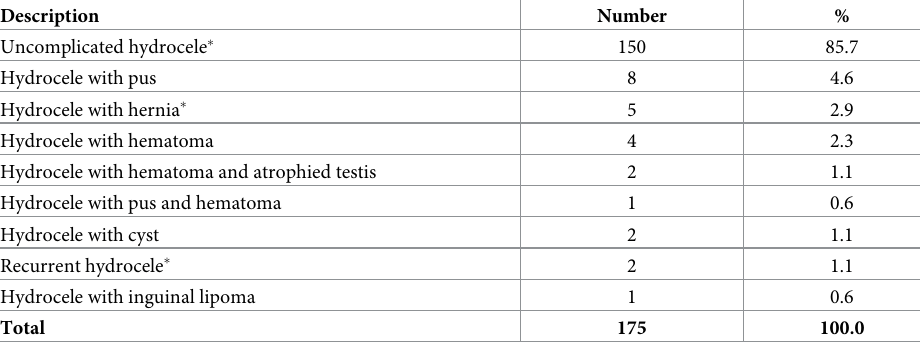
Table 2. Operative findings of hydrocele.